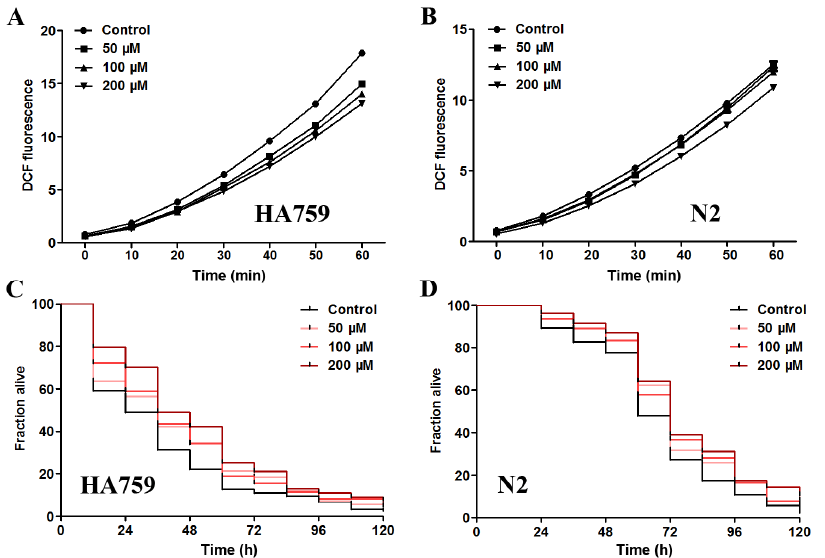
Figure 4. Effect of salidroside on ROS level and oxidative survival in C. elegans . ( A , B ) Salidroside decreased ROS level of HA759 and N2 nematodes. The nematodes were treated from L1 with salidroside at 20 °C for 72 h and then lysed for determination of ROS level by DCF assay every 10 min for 60 min. Data are representative of three independent experiments and presented as mean ± SD; ( C , D ) Salidroside increased the survival rates of paraquat-intoxicated polyQ HA759 and wild-type N2 nematodes, respectively. After treatment with salidroside at 20 °C for 48 h from young adult stage, the nematodes were exposed to 0.1 M paraquat and scored every 12 h for survival rate. Representative Kaplan–Meier survival curves are shown from three independent